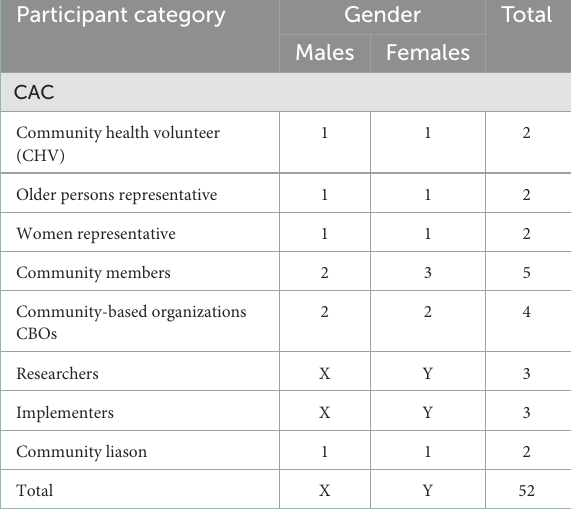
TABLE 2 Study themes and